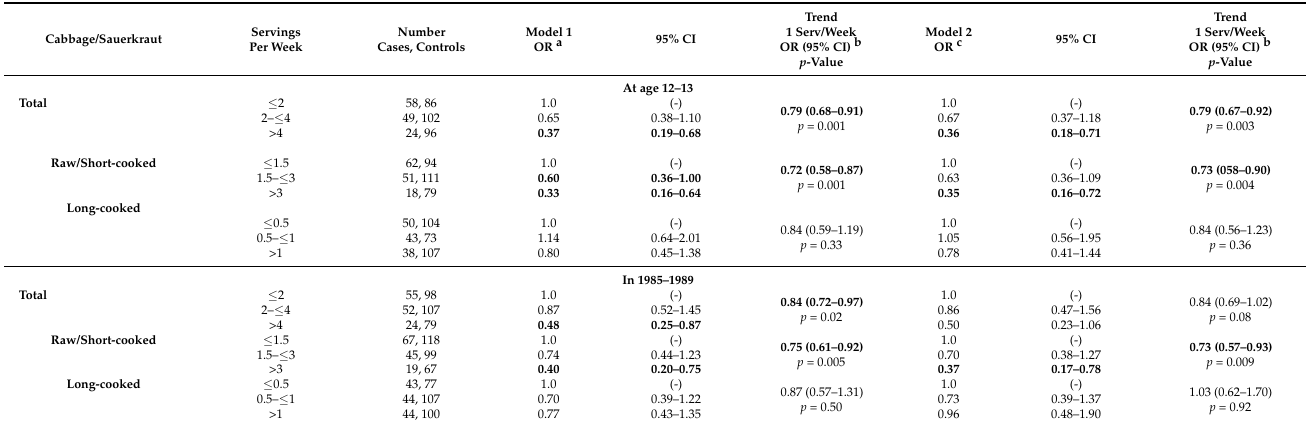
Table 3. Risk of breast cancer in association with intake of cabbage/sauerkraut foods during adolescence or adulthood amongst Polish-born women residing in Cook County, IL or the Detroit Metropolitan Area, MI.